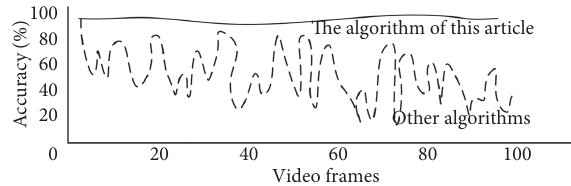
Figure 8: Simulation results of platform